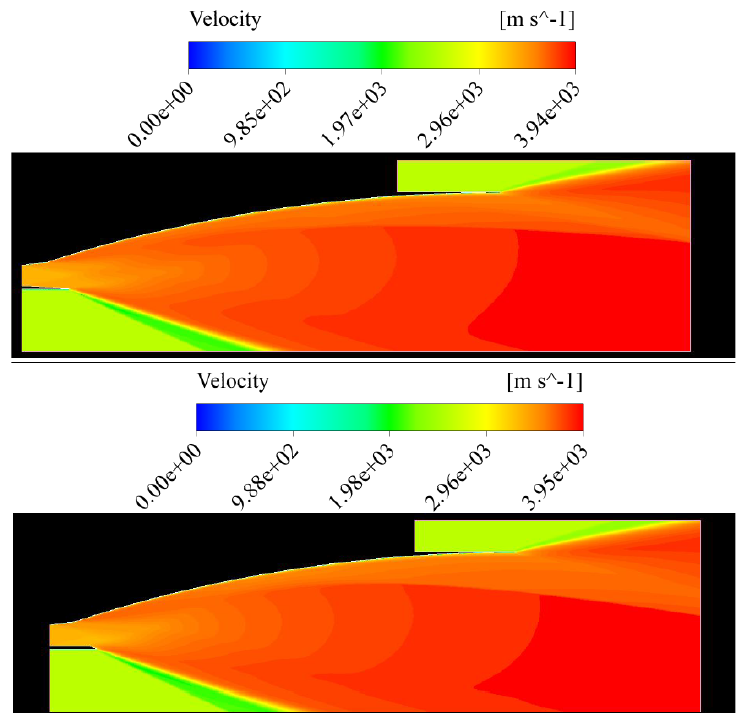
Figure 11. Contours of velocity for DP 464 ( top ) and DP 102 ( bottom ).